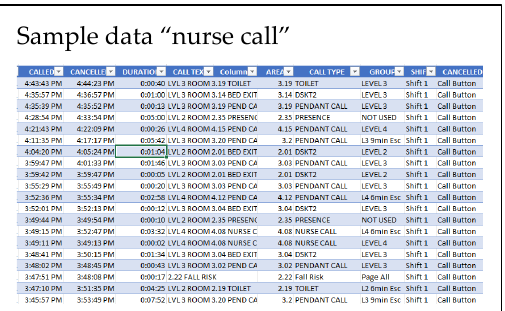
Figure 26. “ Nurse call” data sample.